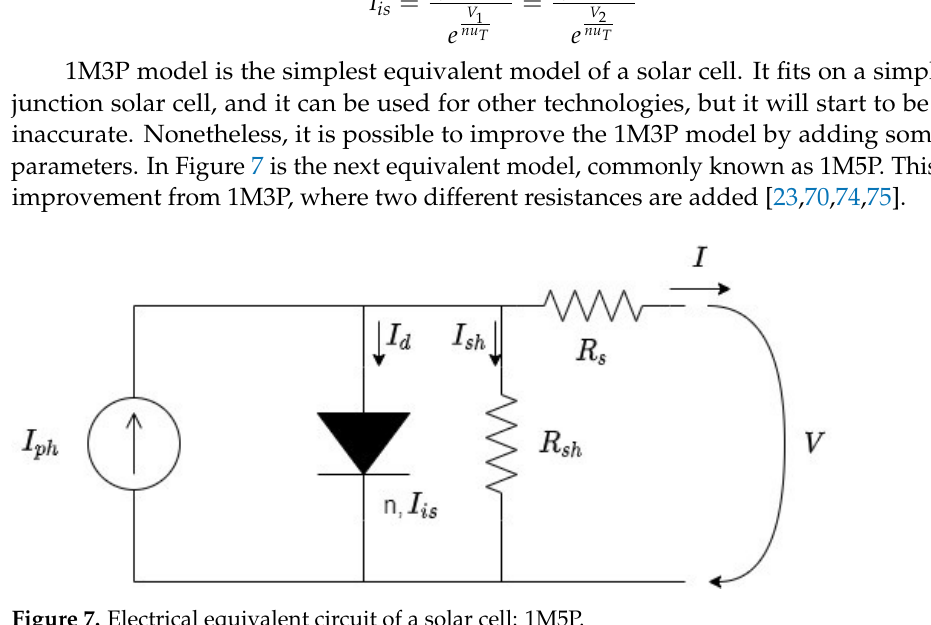
Figure 7. Electrical equivalent circuit of a solar cell: